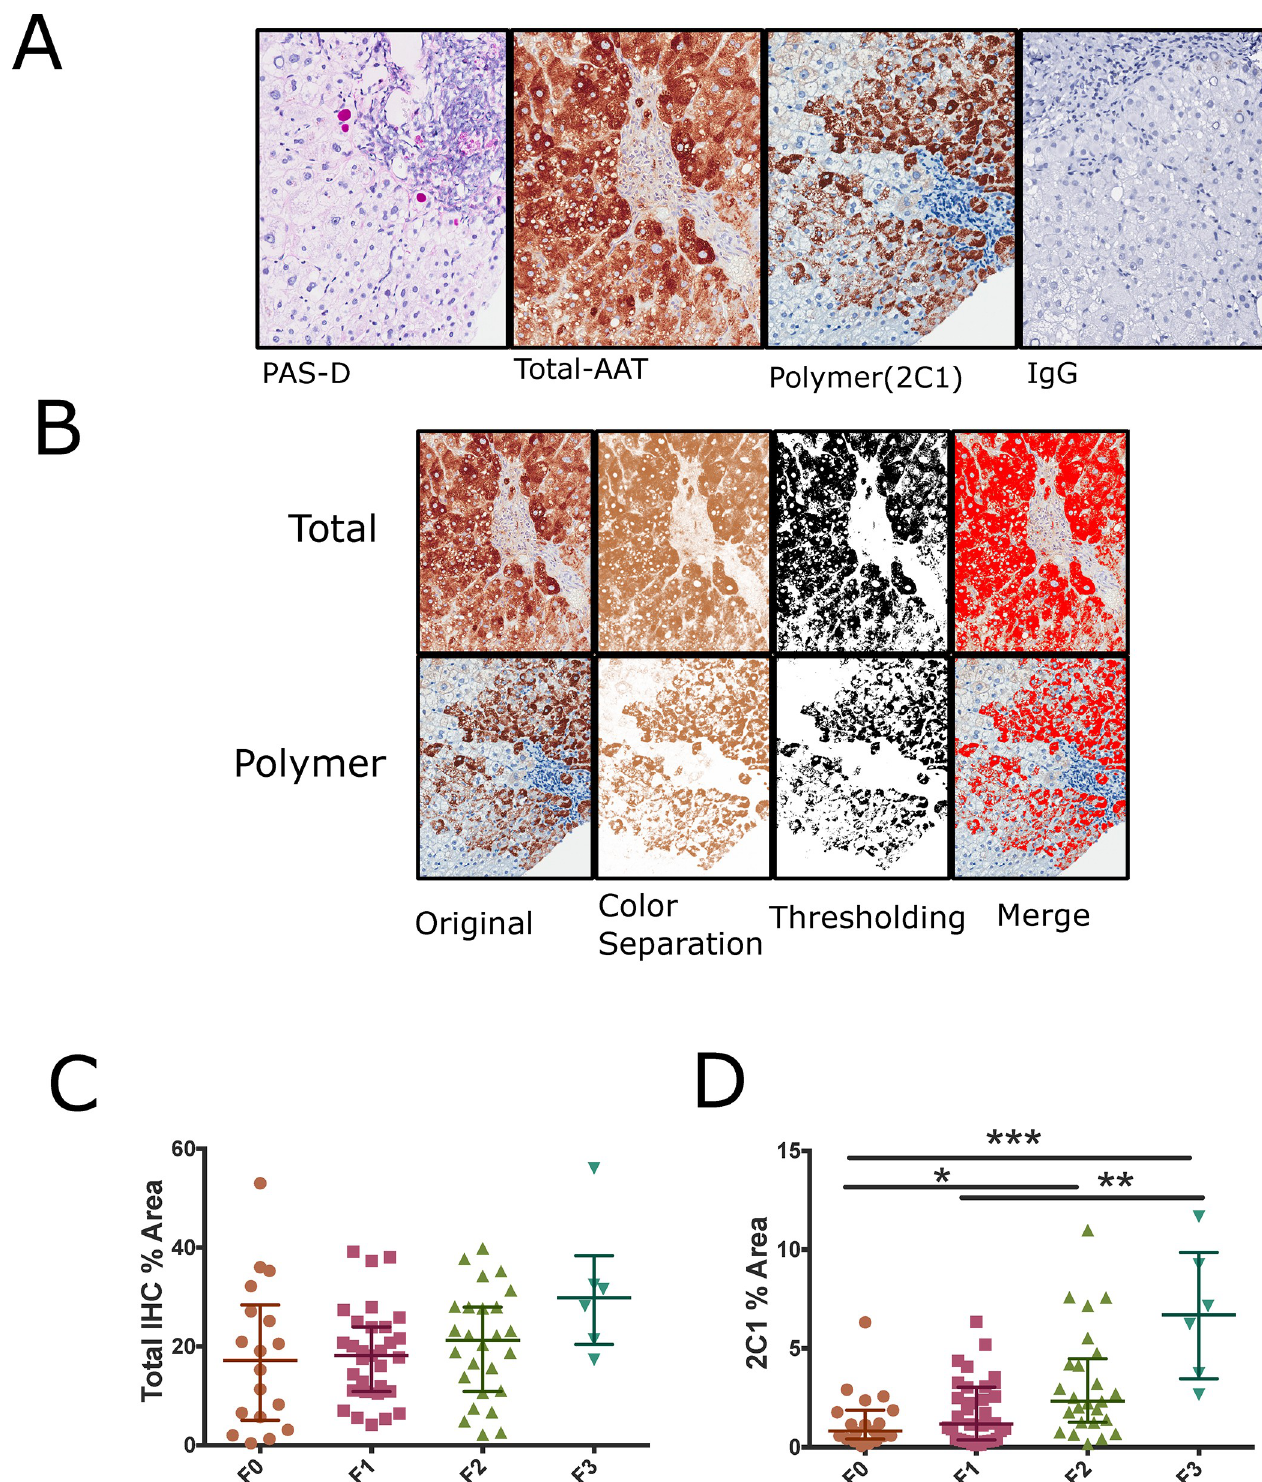
Fig 2. Polymer IHC % area is a complementary measure of AAT accumulation. (A) Semi-serial sections of PAS-D, Total and Polymer AATD with IgG control (B) Representation of IHC threshold-based quantification of AATD liver (C) (D) Quantification of total and polymer specific immunohistochemistry across METAVIR fibrosis stages Kruskal-Wallis testing with Dunn’s multiple comparisons � p < 0.05, �� p < 0.01. ��� p < 0.0001 bars represent median and IQR, points represent measurement from individual whole slide images.